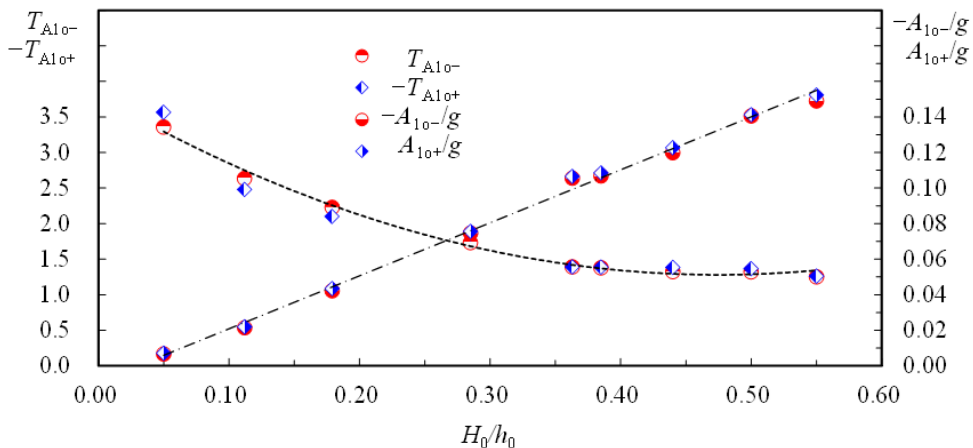
Figure 16. The relationships of T Alo+ and T Alo − as well as A lo+ / g and A lo_ / g versus H 0 / h 0 .